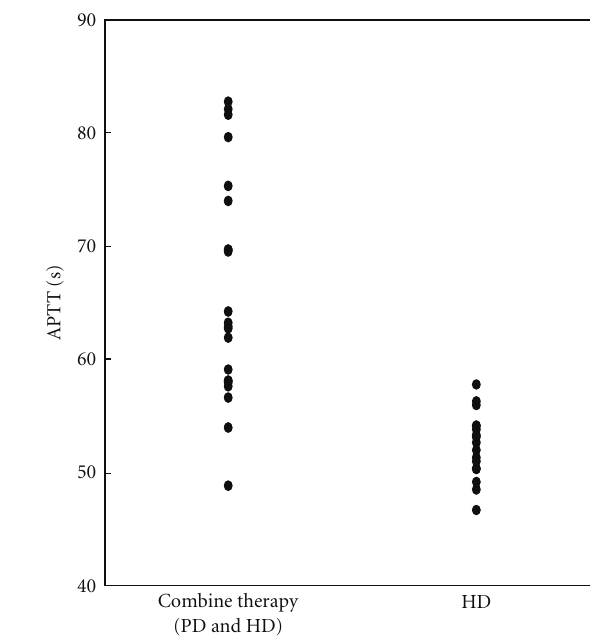
Figure 2: The activated partial thromboplastin time during com- bined therapy with peritoneal dialysis (PD) and hemodialysis (HD) or HD. (65 . 9 ± 9 . 9 versus 52 . 3 ± 2 . 9, P < 0 . 01). APTT: activated partial thromboplastin